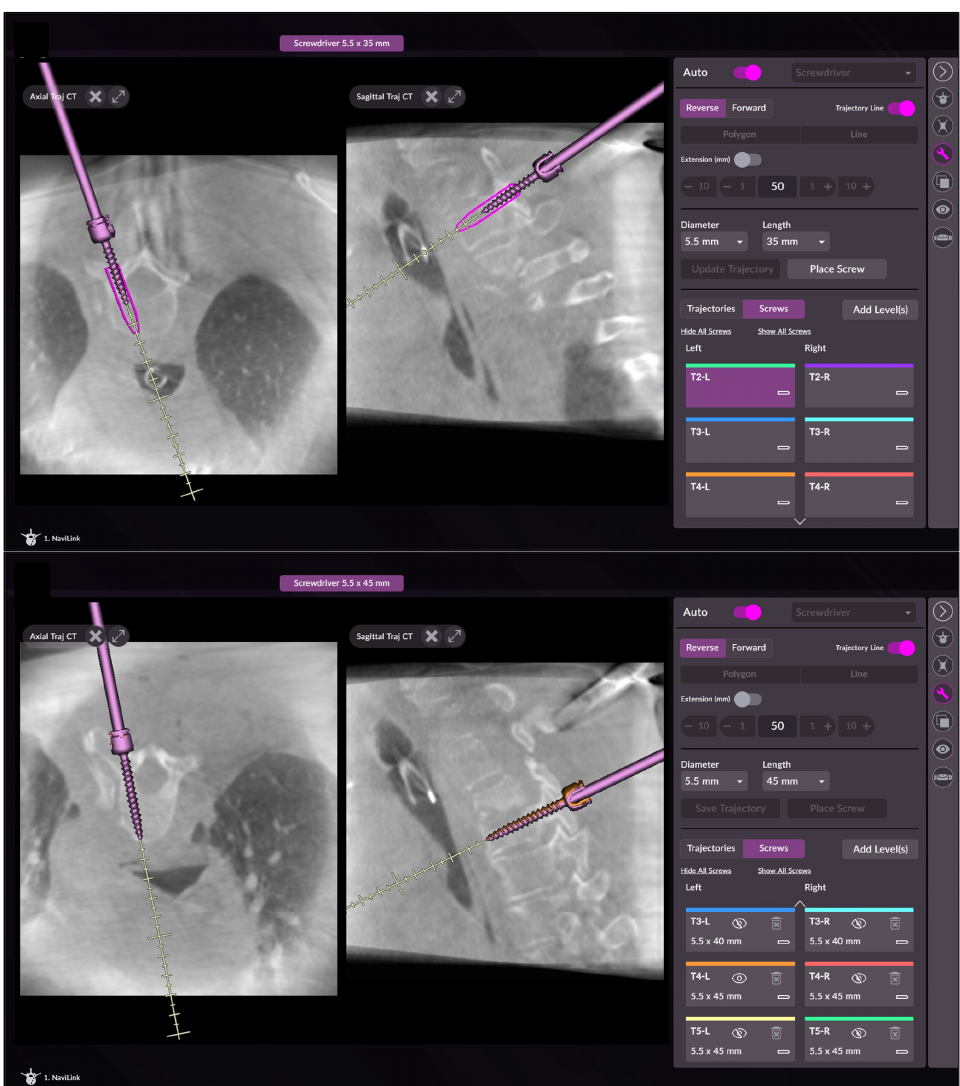
Figure 3. Screenshots of the navigation software during screw insertion with visualization of the planned position of the screw and with the correctly positioned